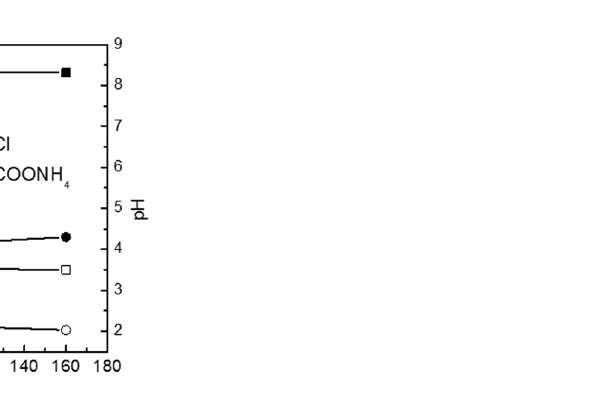
Figure 10. Evolutions of ammonia conversion and pH of NH 4 Cl and CH 3 COONH 4 solutions over Pt/TiO 2 catalyst. Conditions: [NH